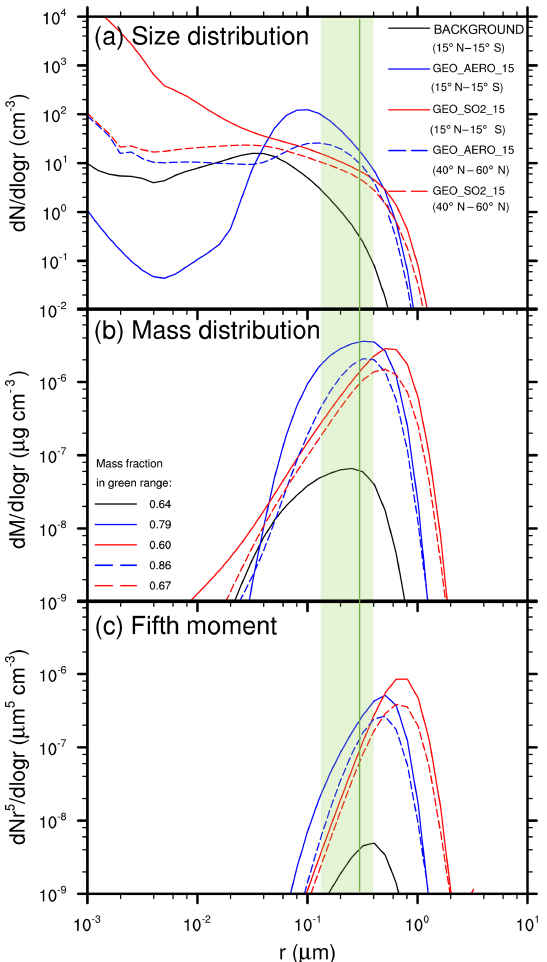
Figure 2. Size and mass distributions of stratospheric aerosol under various scenarios. (a) Wet aerosol size distributions of GEO_AERO_15 (blue), GEO_SO2_15 (red) and BACKGROUND (black) are zonally averaged over 10 years between 15 ◦ N and 15 ◦ S (continuous lines) and between 40 and 60 ◦ N (dashed lines). Values shown are at 50hPa in the tropics and at 100hPa in the northern midlatitudes, i.e., at the levels of peak aerosol mass concentration in the vertical profile (see Fig. 3). The green size range is defined as the radius at which backscattering efficiency on sulfate aerosols is at least 70% (i.e., 0.12–0.40µm) of its maximal value (solid green line at 0.30µm) following Dykema et al. (2016). (b) The resulting mass distributions of the size distribution curves shown in (a) including the wet aerosol mass fraction in the optimal size range between 0.12 and 0.40µm in the legend. (c) The fifth moment of the aerosol size distribution shown in (a) as an estimate for aerosol sedimentation mass